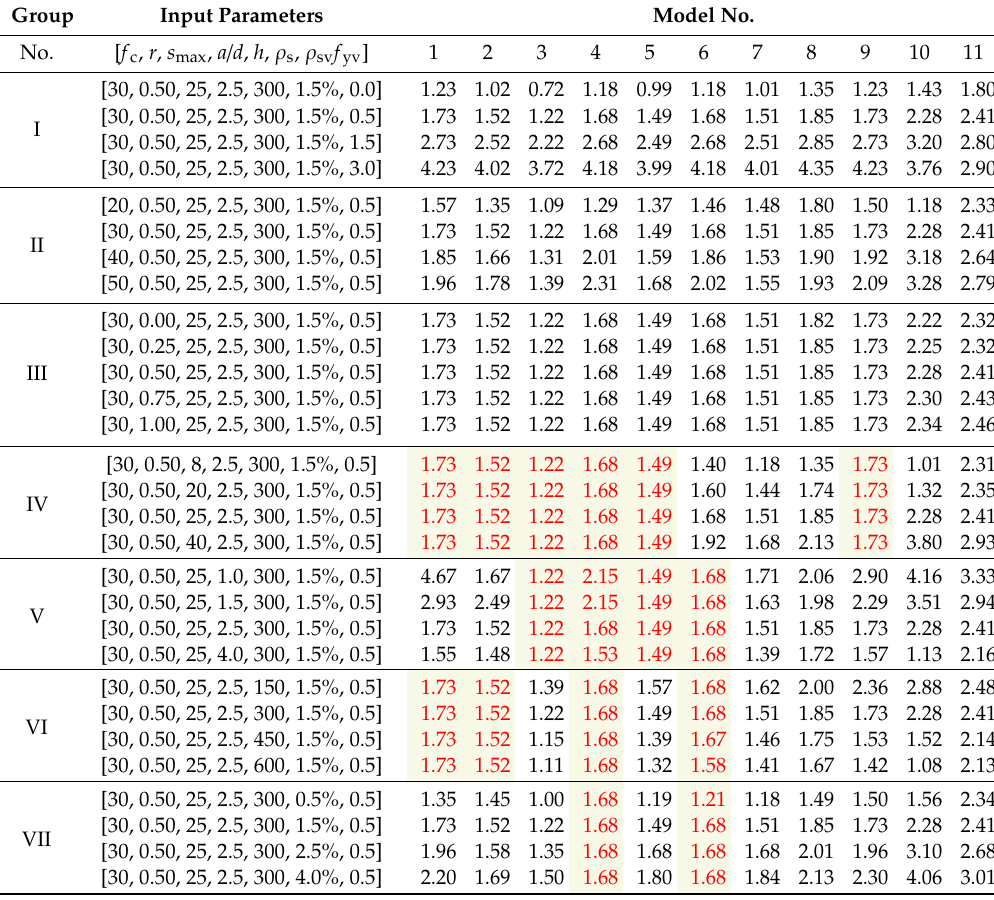
Table 2. Predicted nominal ultimate shear stress v u using di ff erent models.